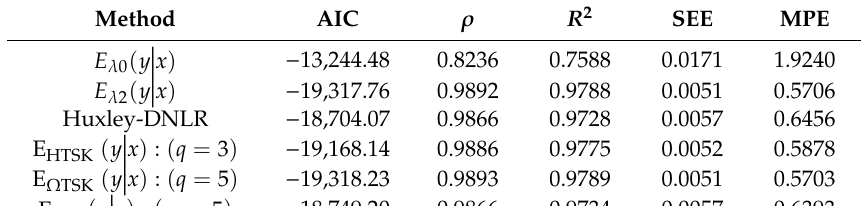
Table1. PerformancemetricsforaddressedproxiesfittedondatasimulatedbytheprocedureofEquation (cid:12) (cid:12) (43) (non–normal errors). E λ 0 ( y (cid:12) x ) stands for back transformed TAMA, E λ 2 ( y λ ( u ) form. Huxley–DNLR refers to Huxley’s model fitted by direct non-linear regression, H 2 stands for the direct scales Takagi–Sugeno–Kang (TSK) fuzzy model regression protocol of Equation (cid:12) (cid:12) (34). E Ω TSK ( y (cid:12) x ) denotes bactransformed form of the geometrical space TSK form Ω TSK ( u ) . Finally, (cid:12) (cid:12) E π m ( y (cid:12) x ) , associates to back transformation of π m ( u ) a direct polynomial representation of MCA in geometrical scales. AIC stands for Akaike’s information criterion, ρ symbolizes Lin’s concordance correlation coe ffi cient, R 2 denotes determination coe ffi cient, SEE standard error of estimation and MPE mean prediction error.